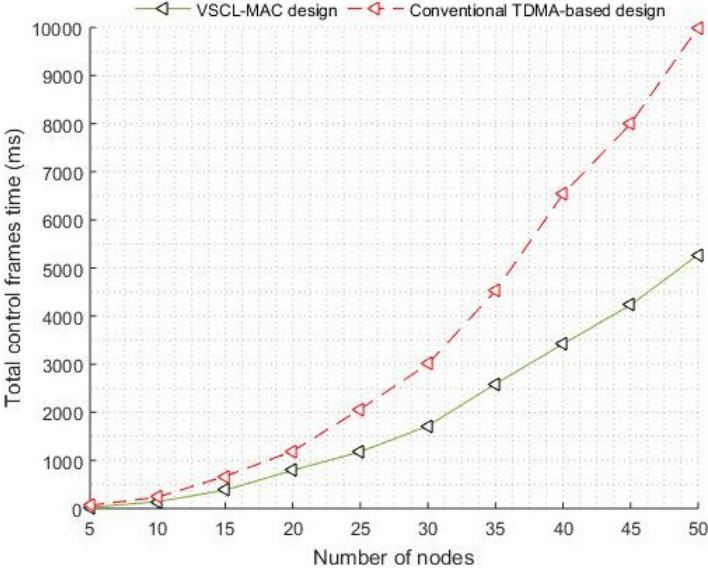
Figure 18. Total control frames transmission time for VSCL-MAC and TDMA-based design.